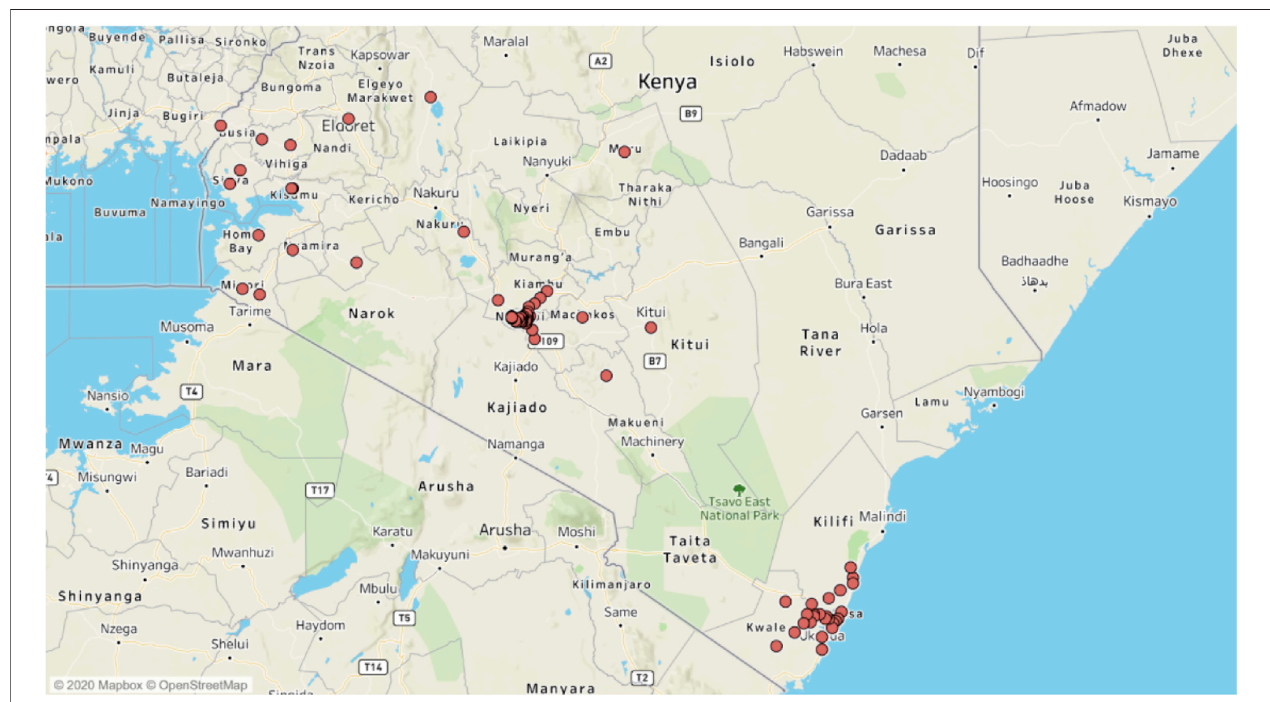
FIGURE 3 | Geographical distribution of Sarafu users (circles represent clusters).